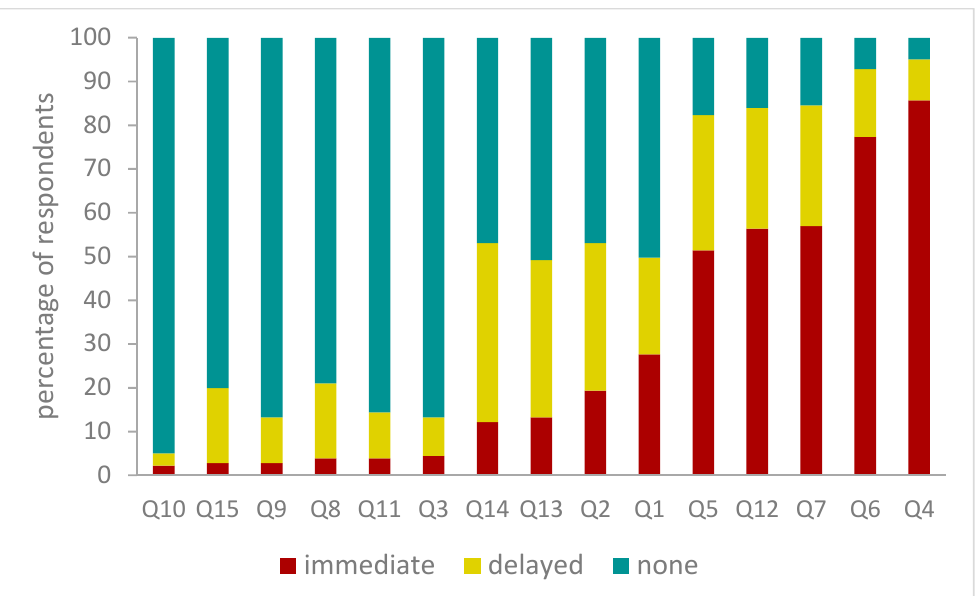
Figure 2. Proportions ultimately choosing immediate, delayed and no prescription per choice